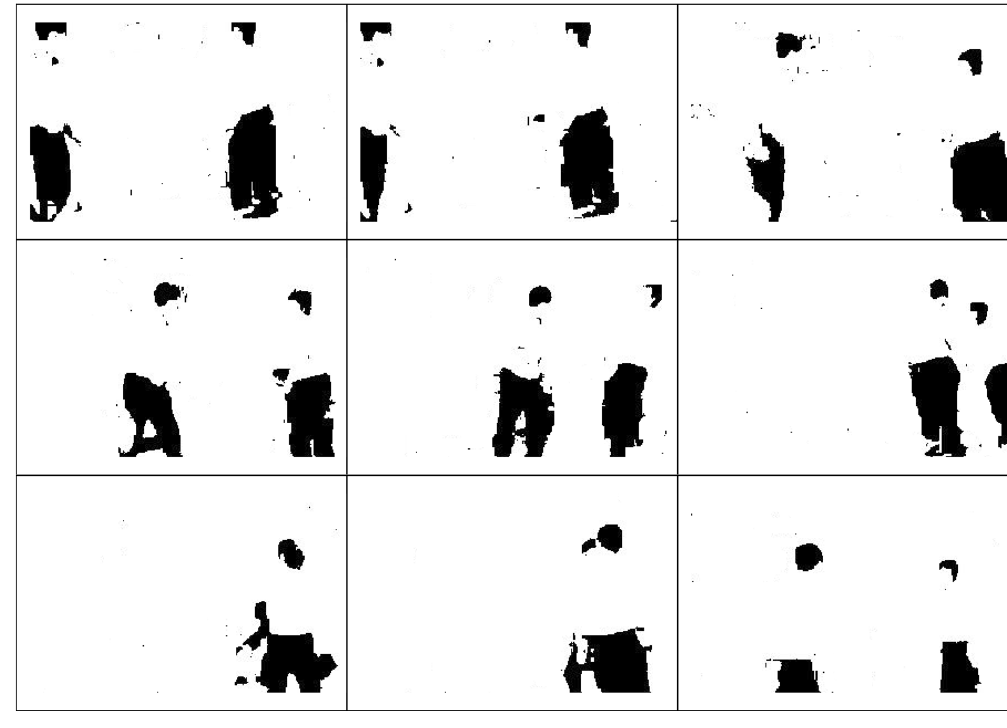
Figure 2. The ROI objects of the first nine